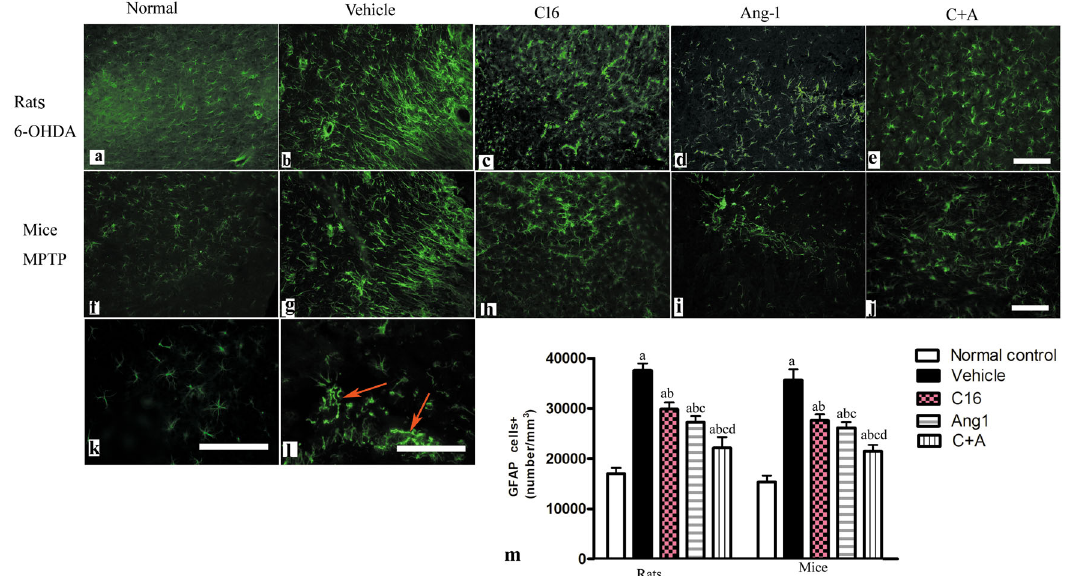
Fig. 11 C16 in combination with Ang-1 treatment supressed the activated astrocytes. a – l The activated astrocytes in the SN were stained with GFAP (green). C16 ( c , h ), Ang-1 ( d , i ), and especially the C + A treatment ( e , j ) suppressed the proliferation of astrocytes in vehicle-treated PD models ( b , g ). Panel k shows astrocytes in the normal control group. Panel l shows the proliferated glial cells and glial scar (red arrow in l ) in the vehicle-treated group in high magni fi cation. Scale bar = 100 µm. m Stereological analysis of GFAP + cells. a p < 0.05 versus the normal control group; b p < 0.05 versus the vehicle group; c p < 0.05 versus the C16-treated group; d p < 0.05 versus the Ang-1-treated group. GFAP, glial fi brillary acidic protein; C16, peptide (KAFDITYVRLKF) that can selectively bind integrin α ν β 3 ; Ang-1 angiopoietin-1.